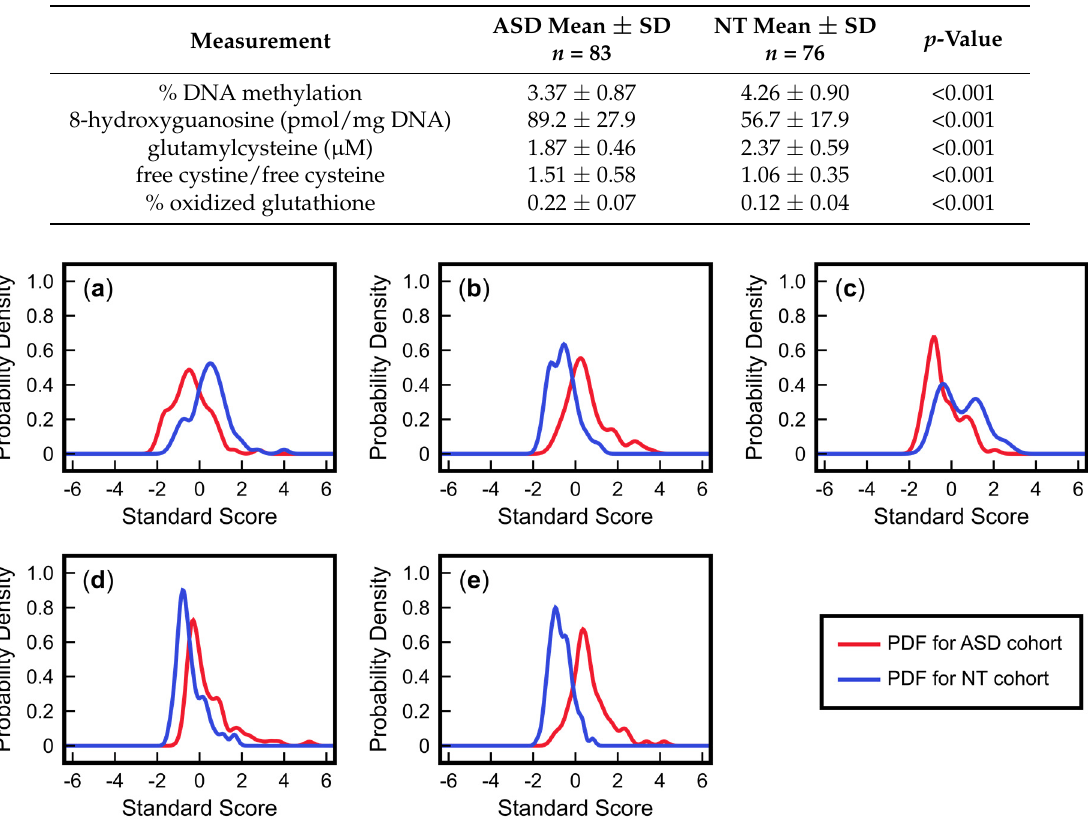
Table 1. Means and standard deviations of five FOCM/TS measurements for the autism spectrum disorder (ASD) and neurotypical (NT) cohorts from the Integrated Metabolic and Genomic Endeavor (IMAGE) study. Reported p ‐ values were obtained from the two ‐ tailed Welch’s t ‐ test. Measurement